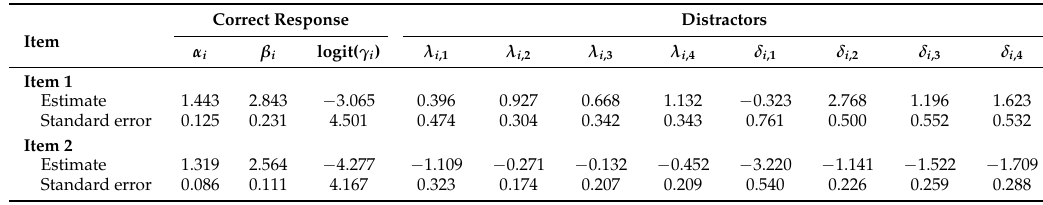
Table 5. Item parameters of the 3PNL